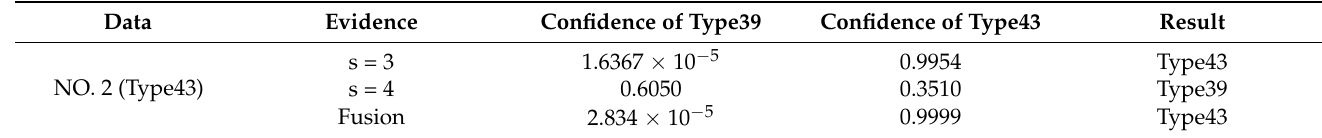
Table 5. Fusion results of misclassified data in scale s = 4.